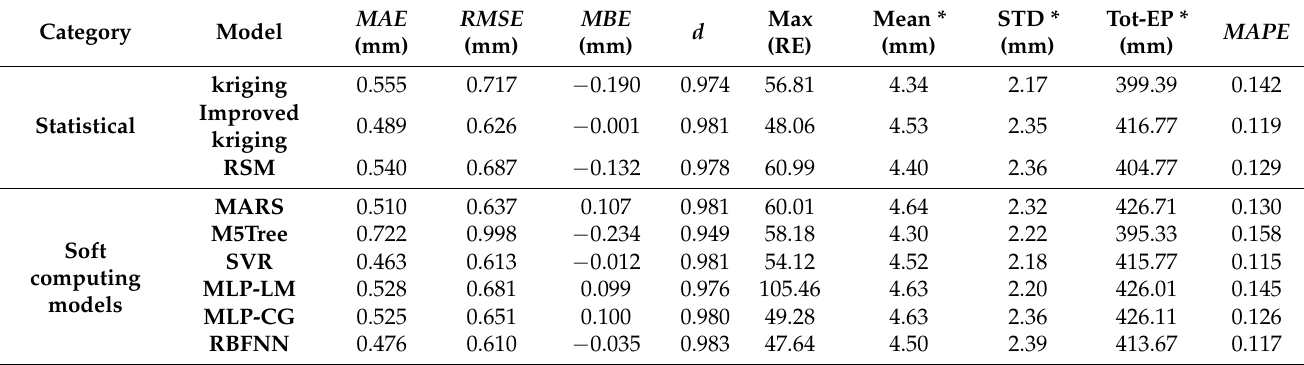
Table 4. Comparison of statistical errors for the applied models without periodicity (scenario #1) for Antakya Station in the testing period.